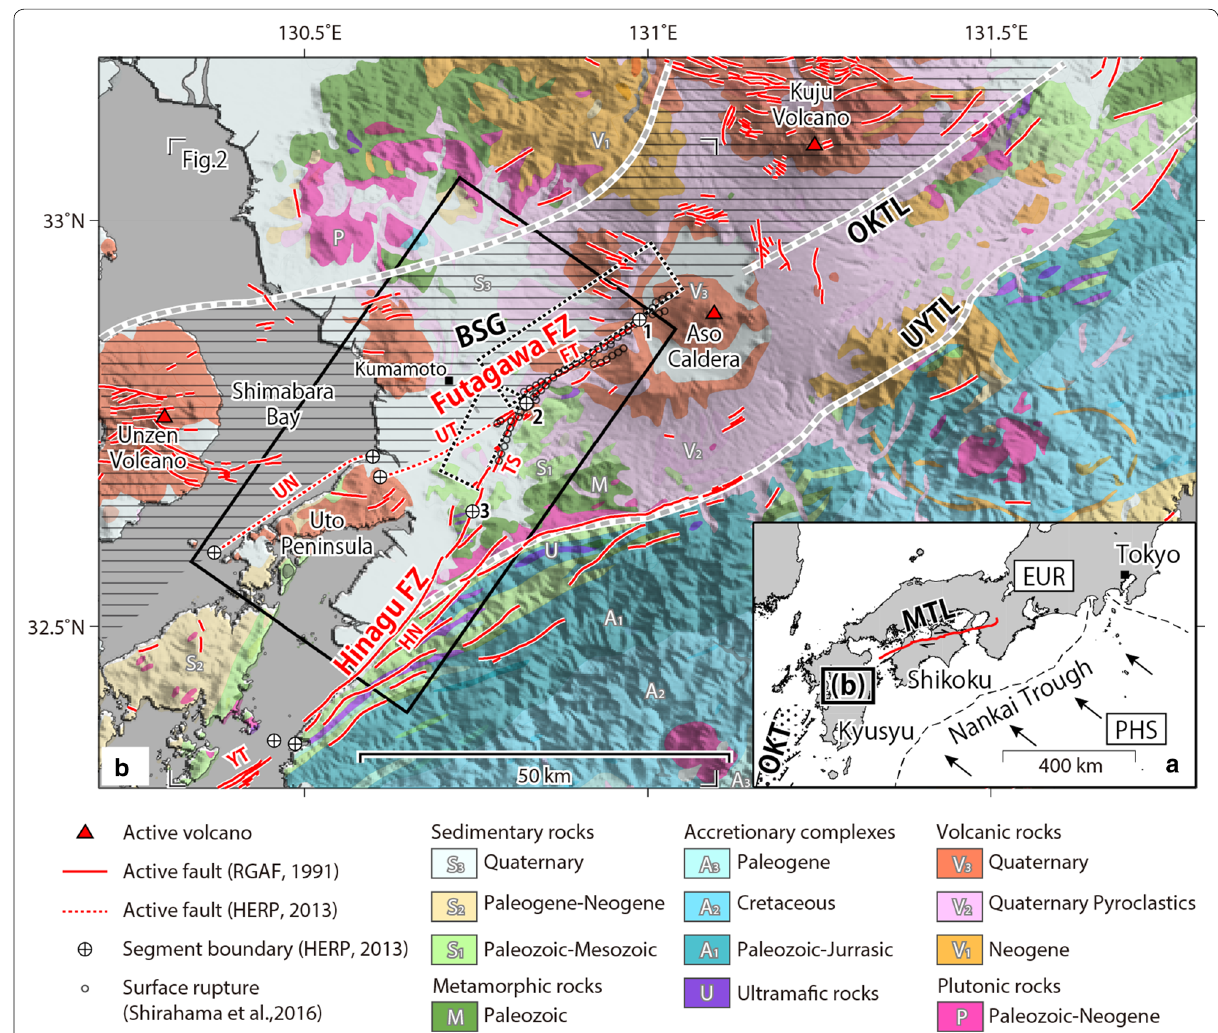
Fig. 1 Tectonic setting of the study area. a Map of southwestern Japan. The Philippine Sea Plate (PHS) is being subducted to the northwest beneath the Eurasian Plate (EUR) along the Nankai Trough. The box shows the study area. MTL Median Tectonic Line, OKT Okinawa Trough. b Geological map of the study area after the Geological Survey of Japan (1995). OKTL Oita–Kumamoto Tectonic Line, UYTL Usuki–Yatsushiro Tectonic Line, BSG Beppu–Shimabara Graben. The fault segments delineated by the Headquarters for Earthquake Research Promotion (HERP) (2013) are marked in red. FT Futagawa segment, UT Uto segment, UN north coast of Uto Peninsula segment, TS Takano–Shirahata segment, HN Hinagu segment, YT Yatsushiro segment, FZ fault zone. The solid rectangle indicates the target area of the tomographic analysis in Fig. 5. The dotted rectangles represent the surface projection of the source fault planes for the mainshock in Asano and Iwata (2016). The solid and dashed red lines denote the active faults determined by RGAF (1991) and HERP (2013),